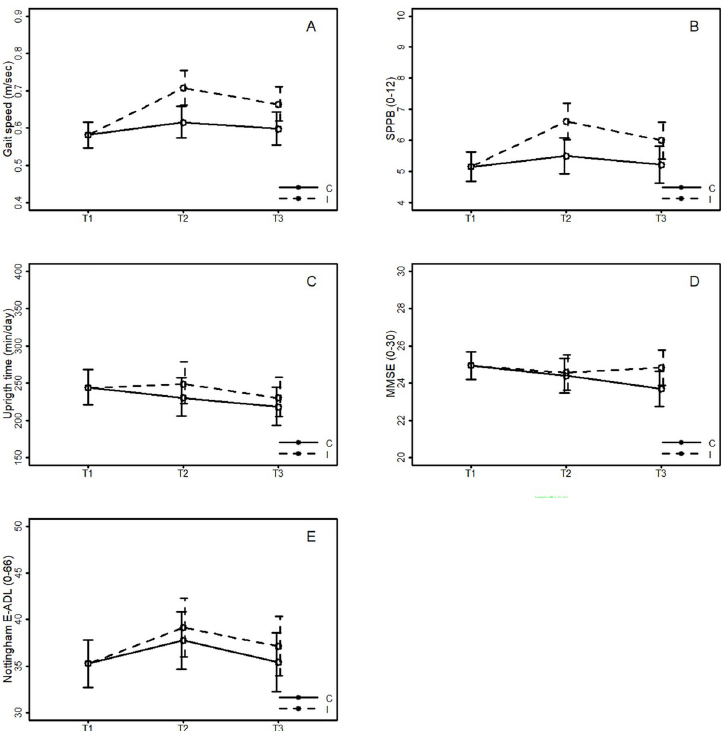
Fig 2. Results from the linear mixed model for the primary outcome, Gait Speed, estimated differences in mean gait speed between the interventions (Intervention (I)–Controls (C)), with 95% CI, and for four secondary outcomes (SPPB, Upright time, MMSE, and Nottingham E-ADL).